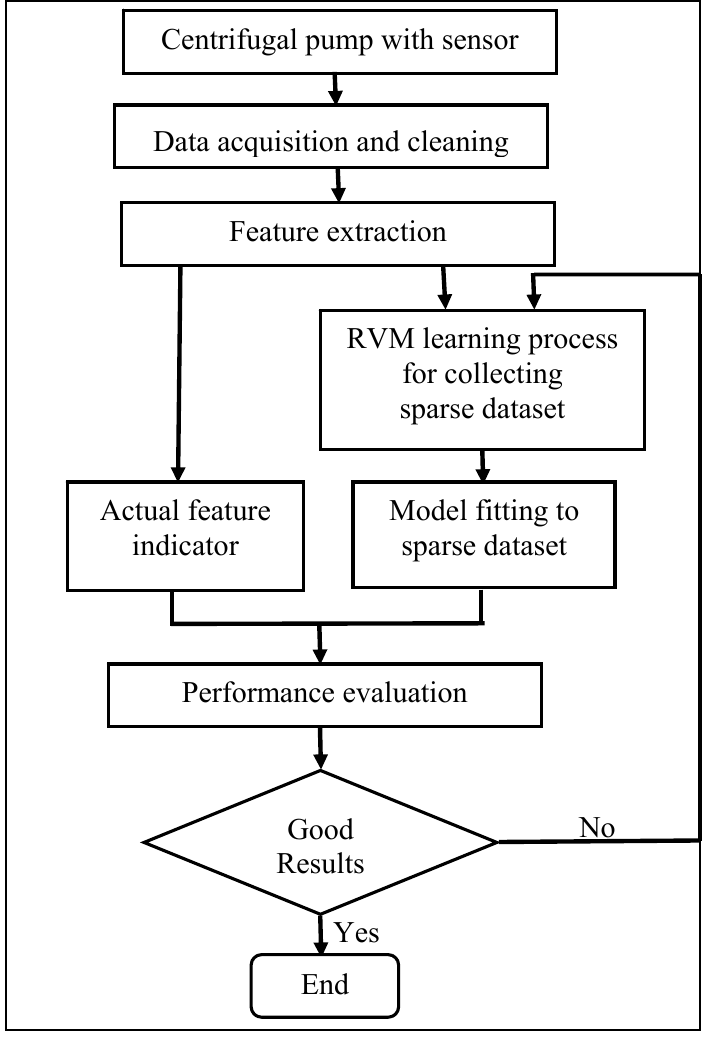
Figure 1. Schematic diagram of the developed